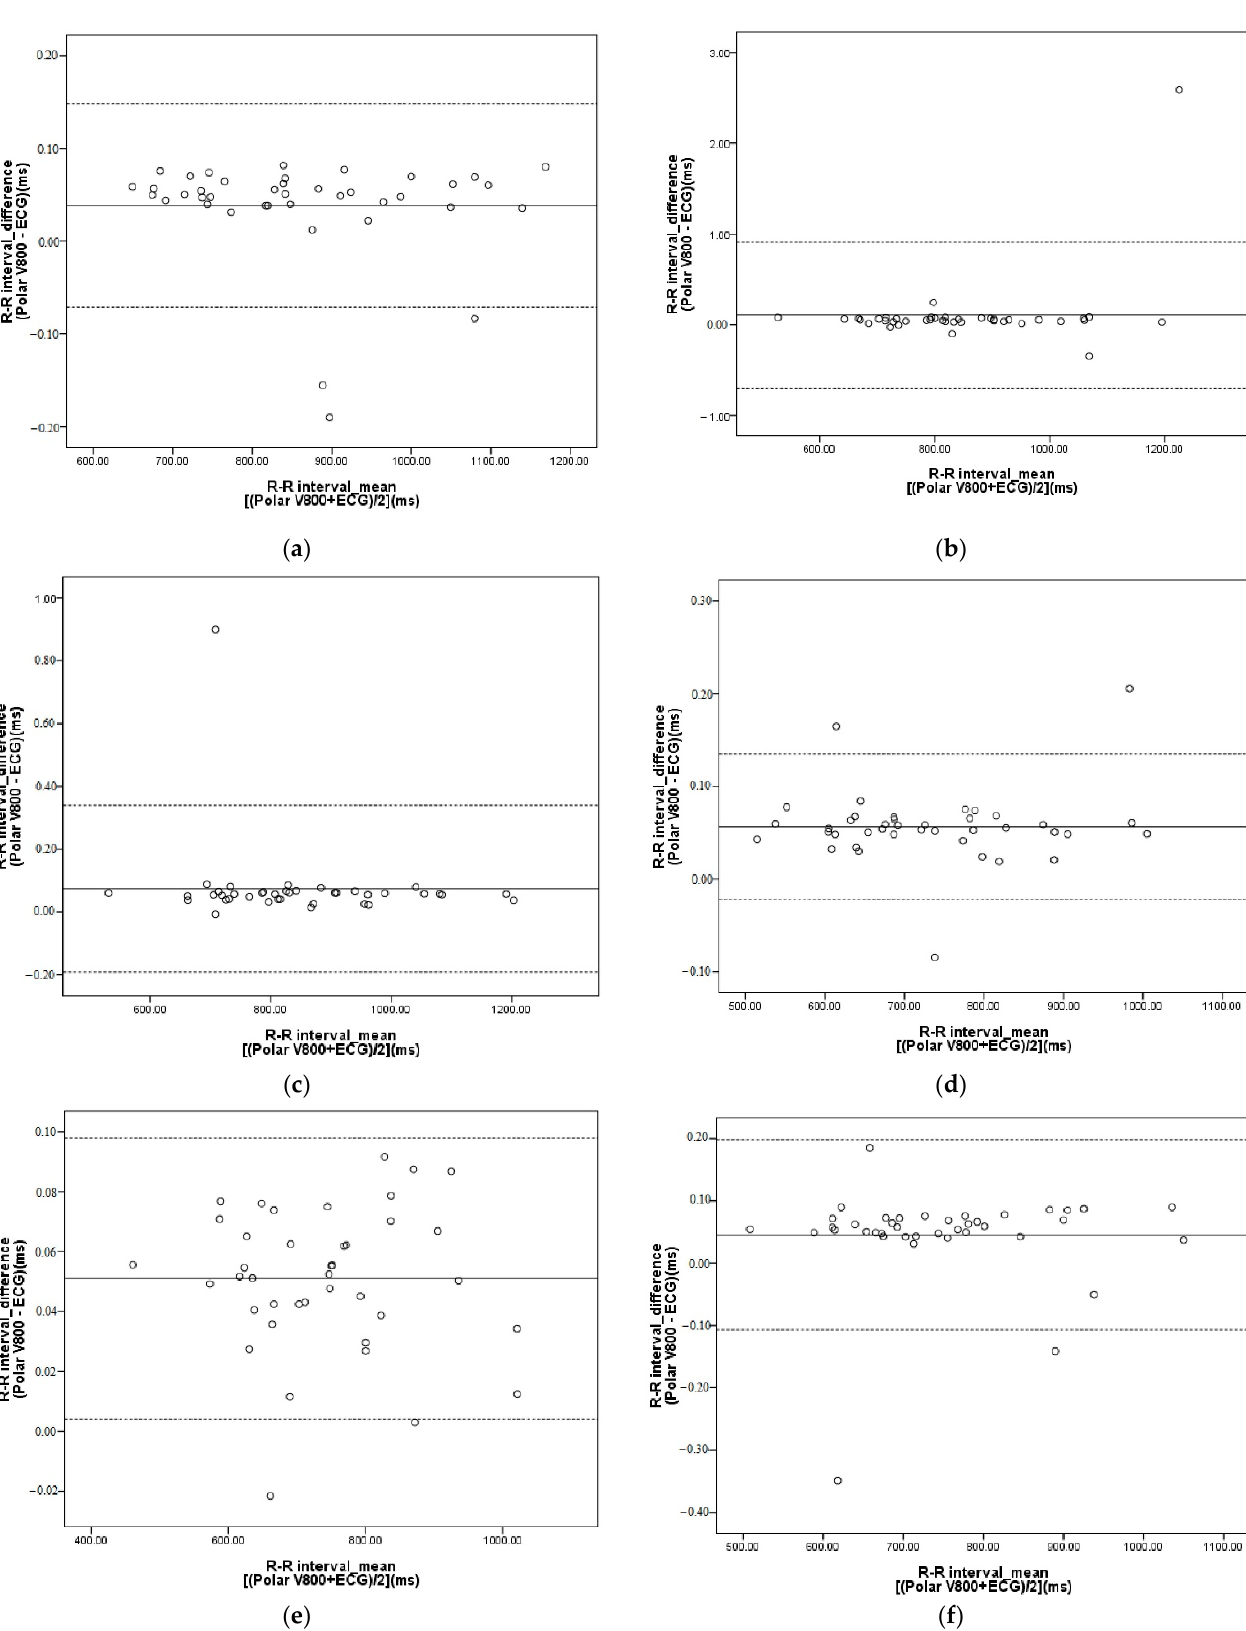
Figure 1. Bland–Altman plot of R-R intervals for the V800 and the ECG. ( a ) Sitting; ( b ) arithmetic test; ( c ) naming test; ( d ) SSWV; ( e ) SSWV performing arithmetic test; ( f ) SSWV performing naming test. Outer dot-dash lines equal ± 1.96 standard deviations of the